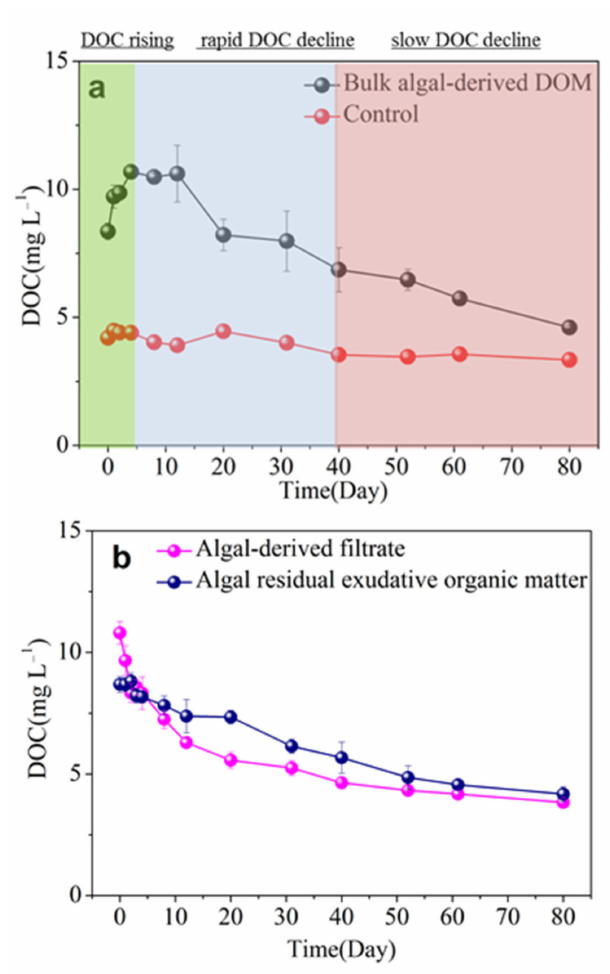
Figure 1. Dynamic changes in dissolved organic carbon (DOC) concentration during the 80-d degradation processes in ( a ) bulk algal-derived dissolved organic matter (DOM) group and natural lake water group (as control), and ( b ) algal-derived filtrate and algal residual exudative organic matter